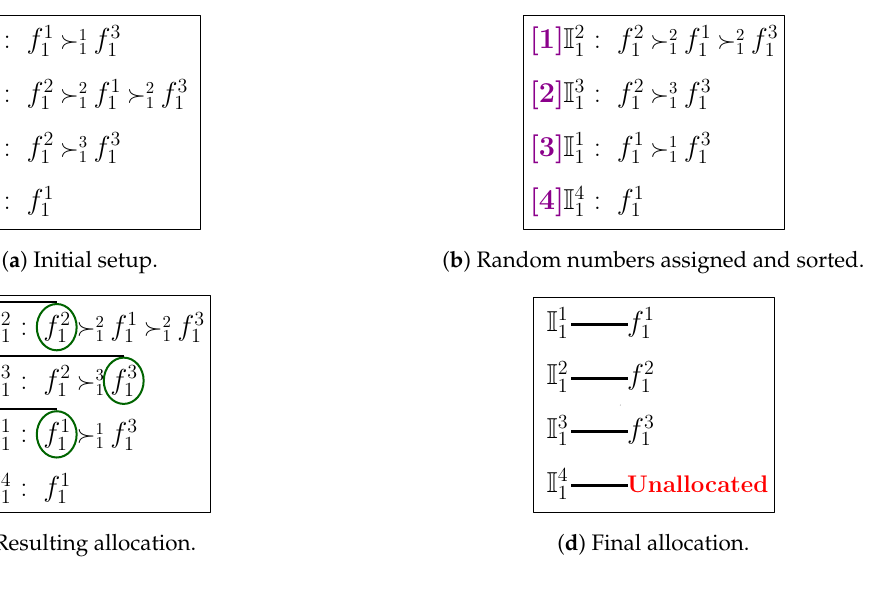
Figure 4. Detailed illustration of